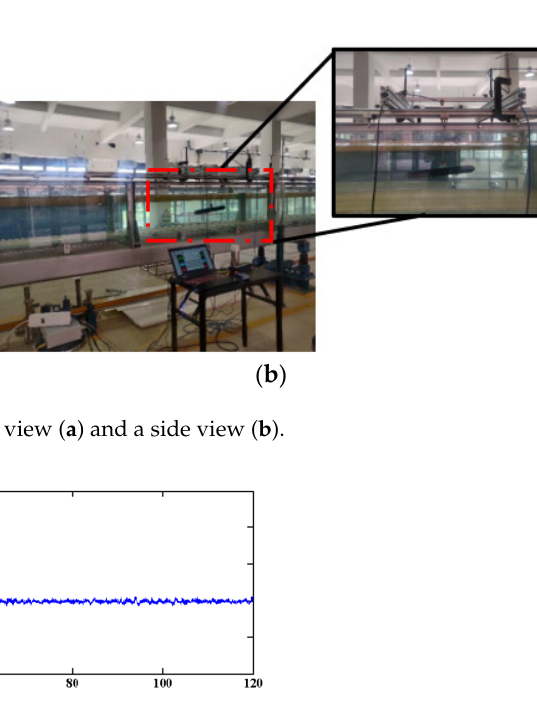
Figure 14. Schematic diagram of the test system.